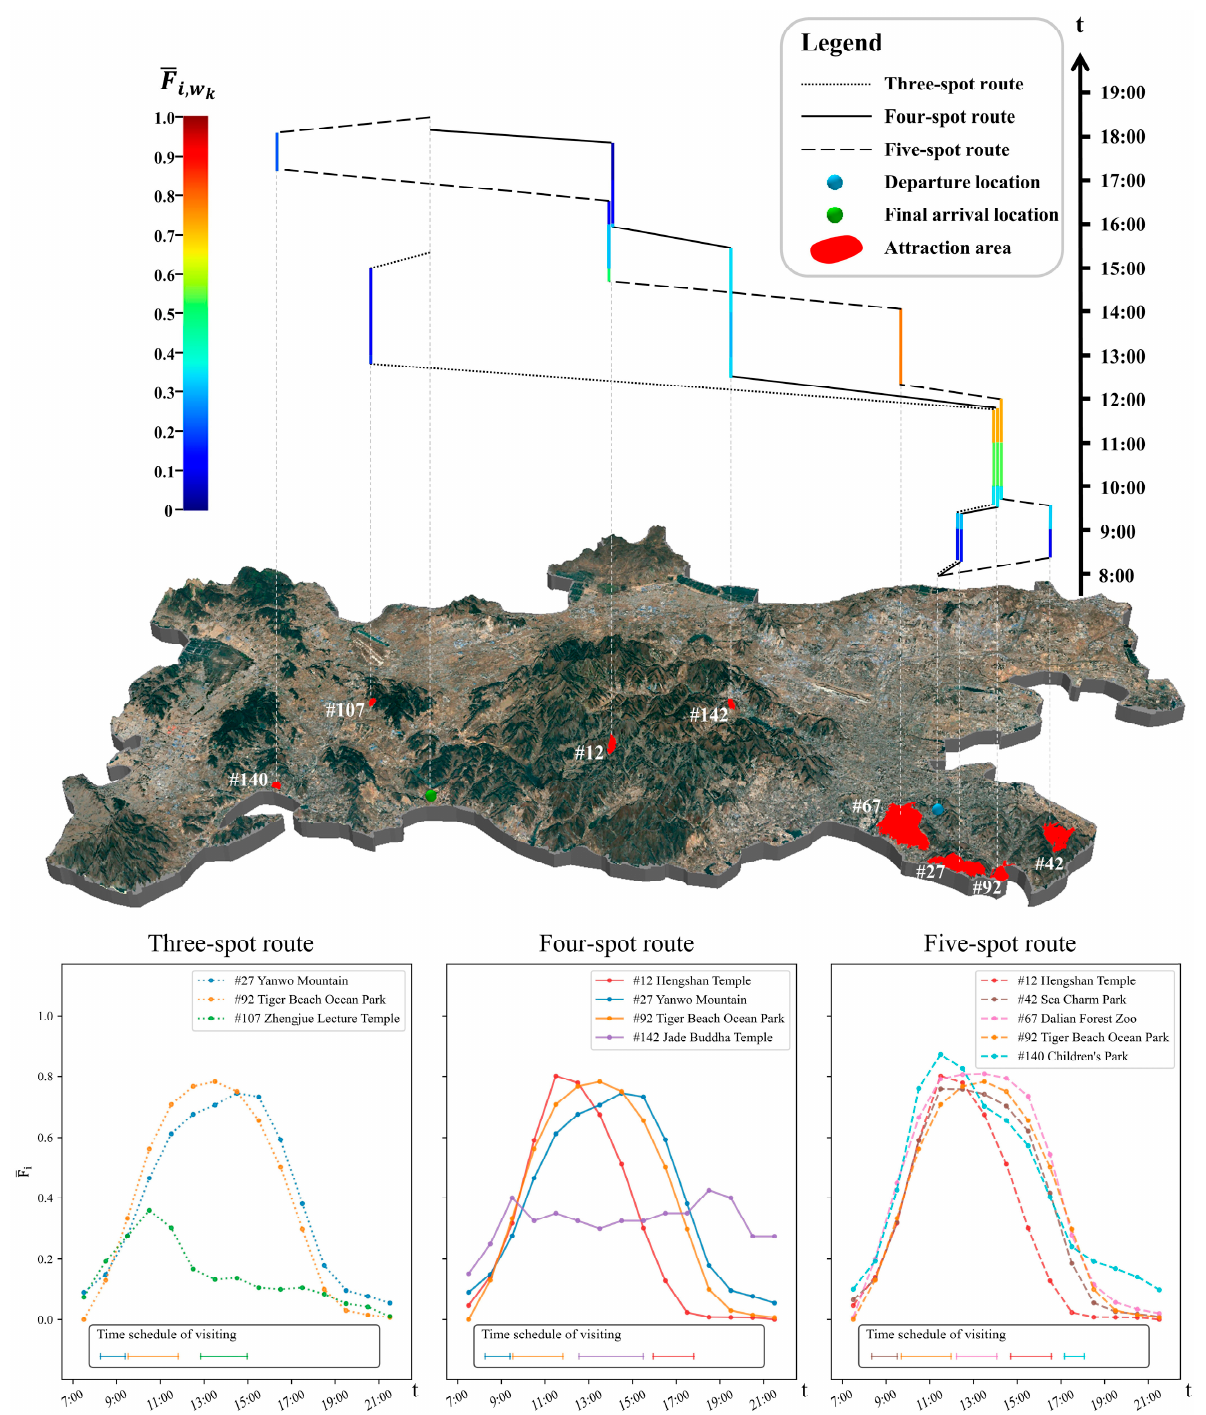
Figure 9. Initial routes designed for the tourist and the historical crowd flow indicator ( F i ) of the involved attractions.